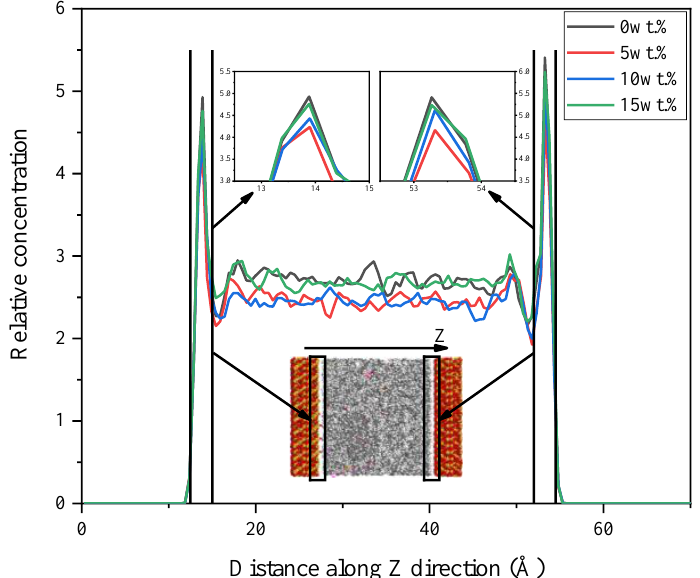
Figure 13. Relative atom concentration of different CNT/VNR composites.